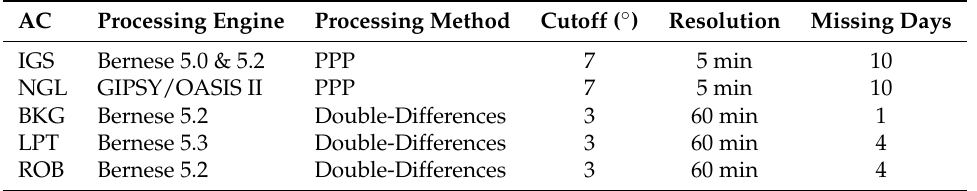
Table 2. Characteristics of reference datasets of the IGS station DLF1. All products are post-processed results using the final satellite orbit and clock